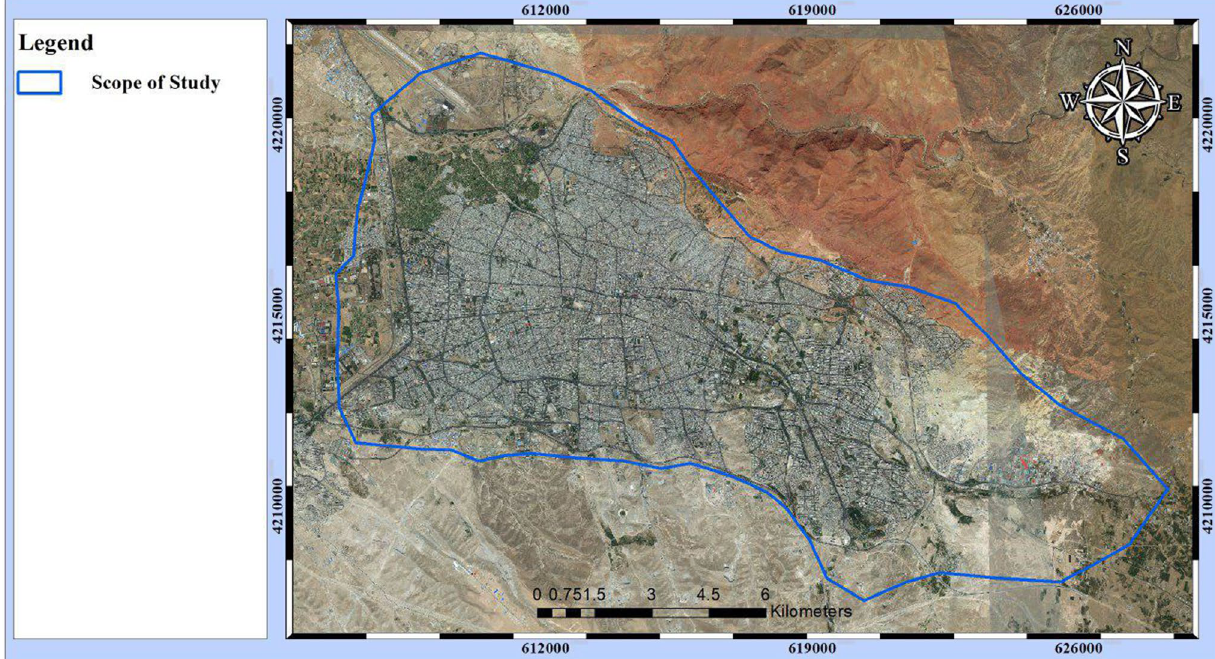
Fig. 1 The scope of the study area